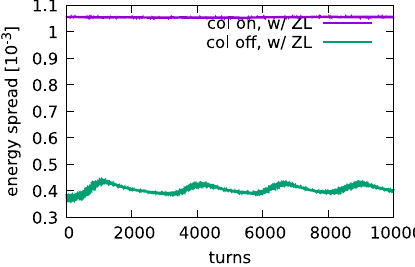
FIG. 4. Evolution of RMS energy spread considering longi- tudinal wakefield (ZL) with and without collision. Beamstrah- lung effect is turned on during collision.